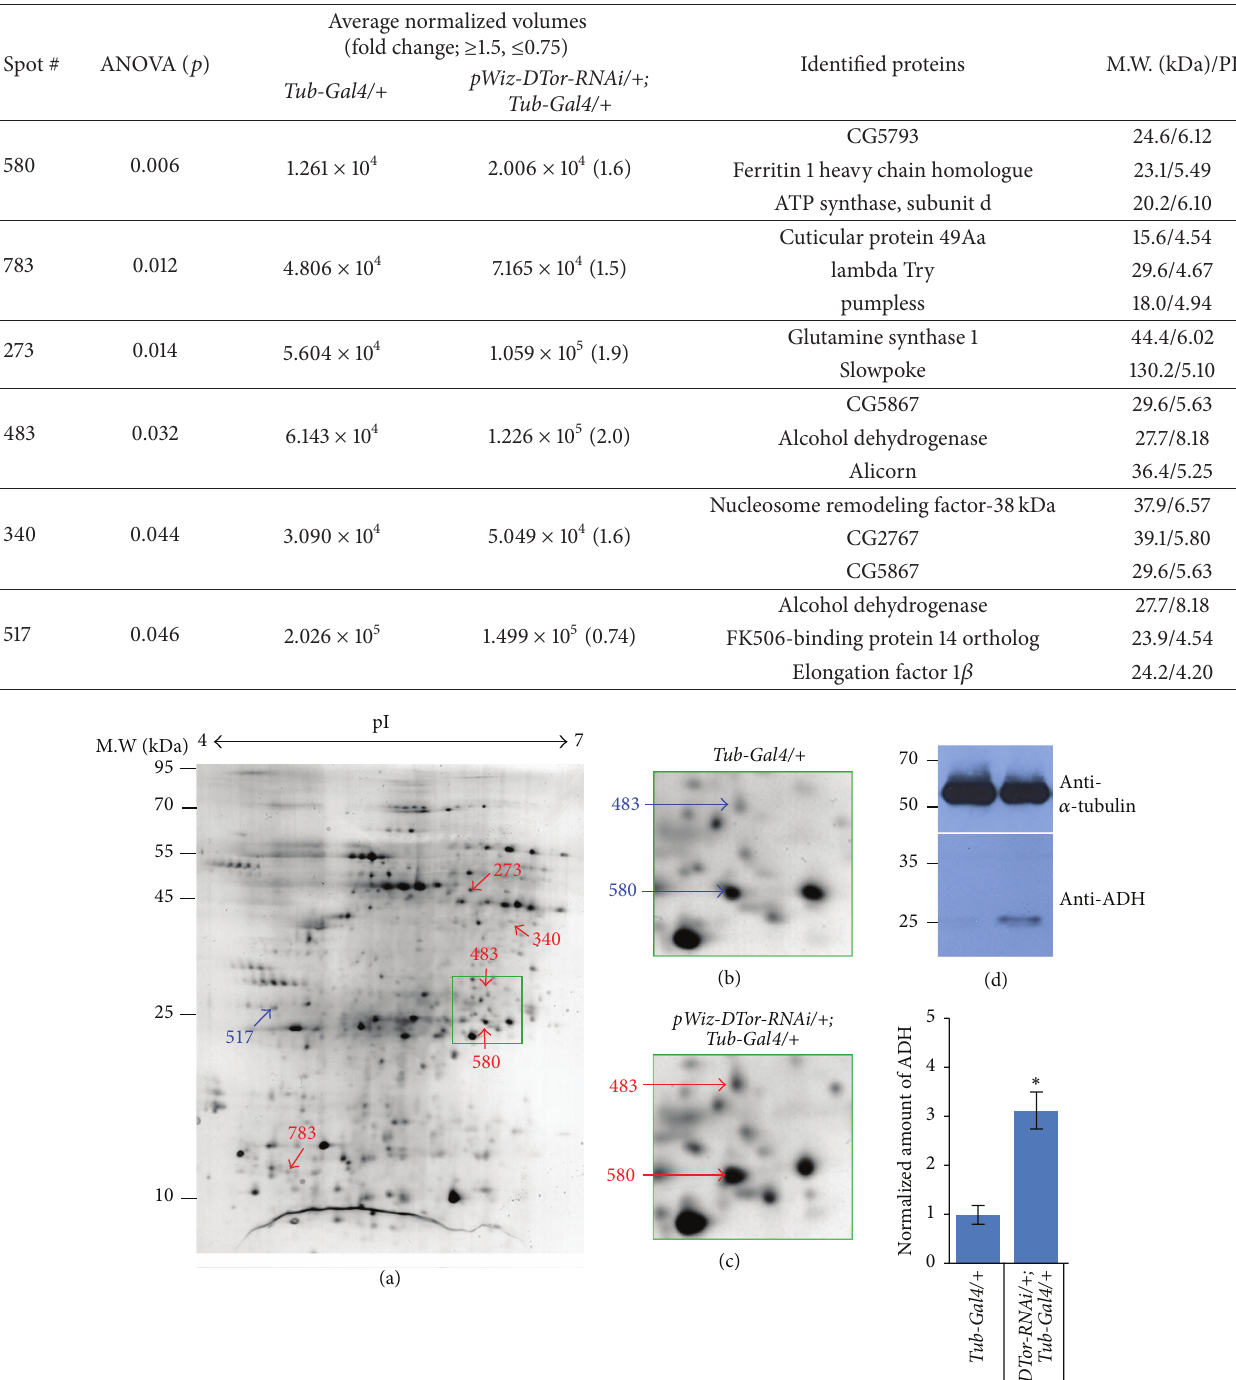
Table 1: The summary of 2D proteomic analysis results.